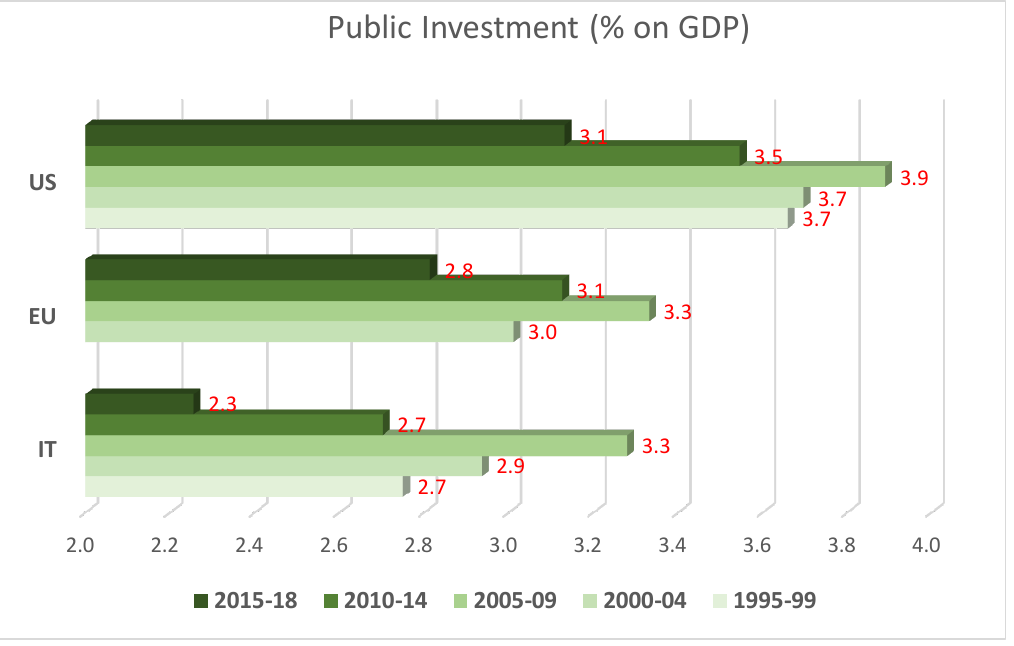
Figure 2: United States, European Union & Italy. Public Investment on GDP